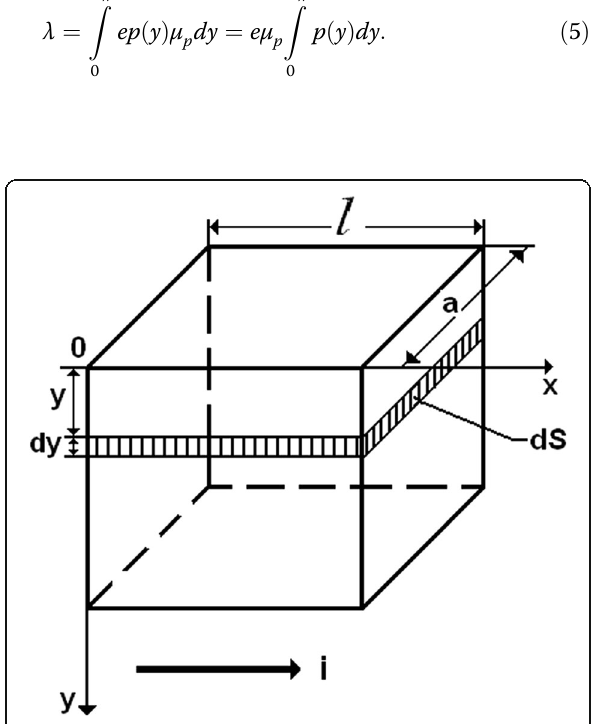
Fig. 6 Calculations of